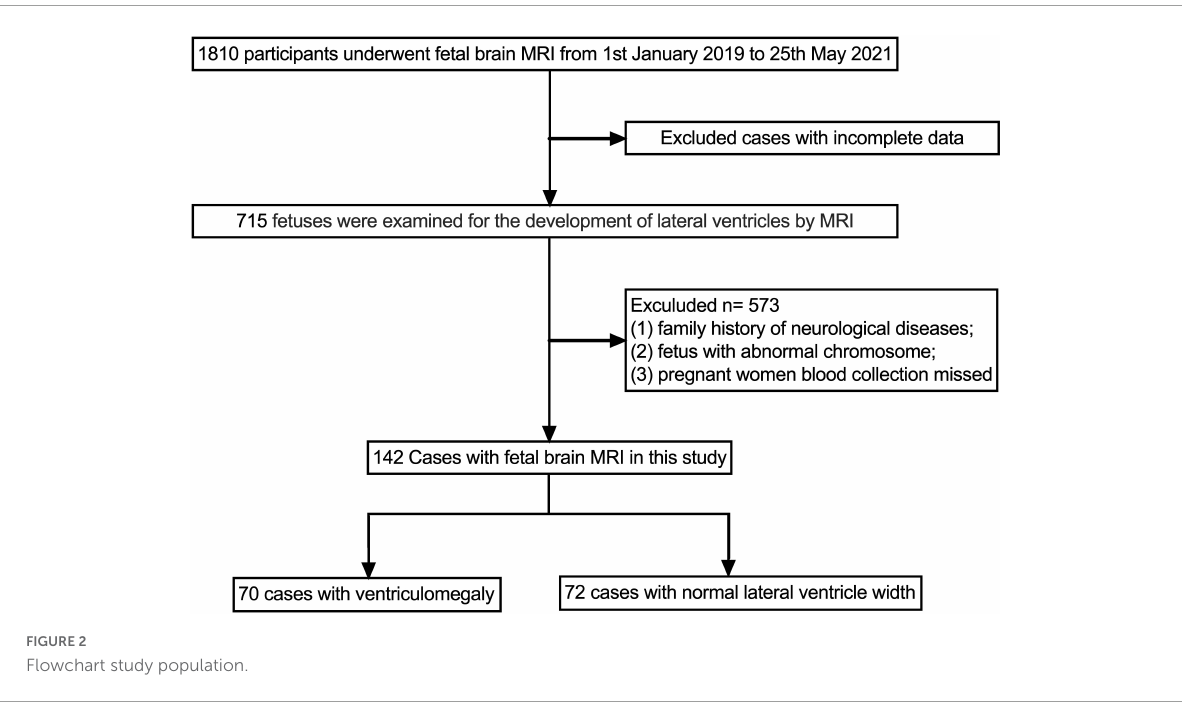
FIGURE2 Flowchart study population.